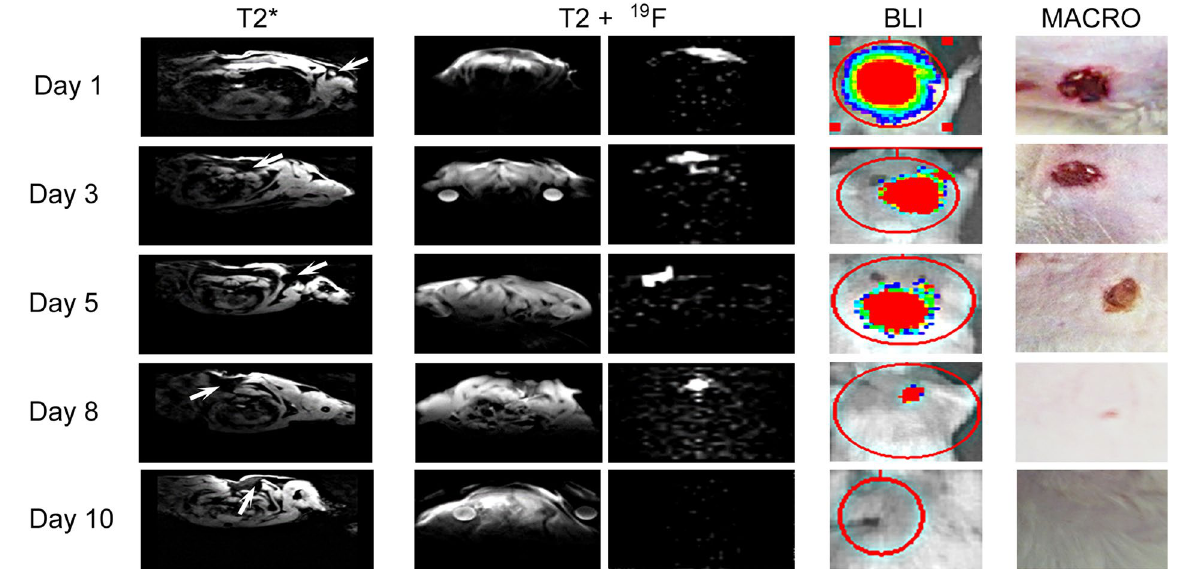
Figure 7. Imaging time course of ASCs and macrophotographs showing the process of wound-healing on an example of transplantation of AA-preconditioned, syngeneic, SPIO- or 19 F-labeled ASCs to young animals. The 19 F images, BLI, and MACRO pictures belong to the same animal, while T2 * images were derived from another animal. Arrows indicate the hypothetical location of iron oxide-labeled cells on T2 * MRI, but data are inconclusive. 19 F MRI shows clear hot spot images of cell deposits. T2w MRI presents an anatomical reference for 19 F MRI. The BLI signal is represented as a color-coded map. The macro pictures depict the time course of wound-healing.